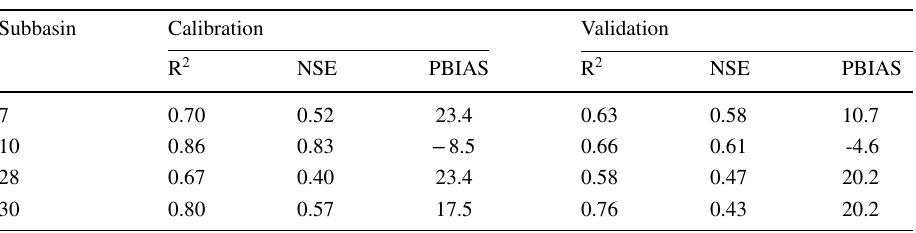
Table 6 Summary of statistical indicators for model performance